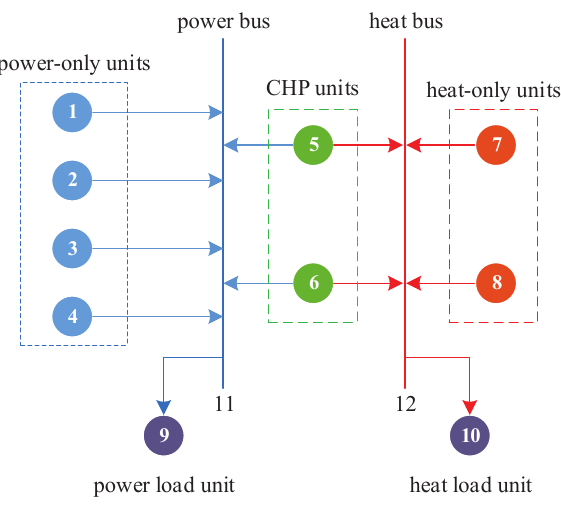
Figure 3. The structure schematic diagram of the 10-unit IPHS.